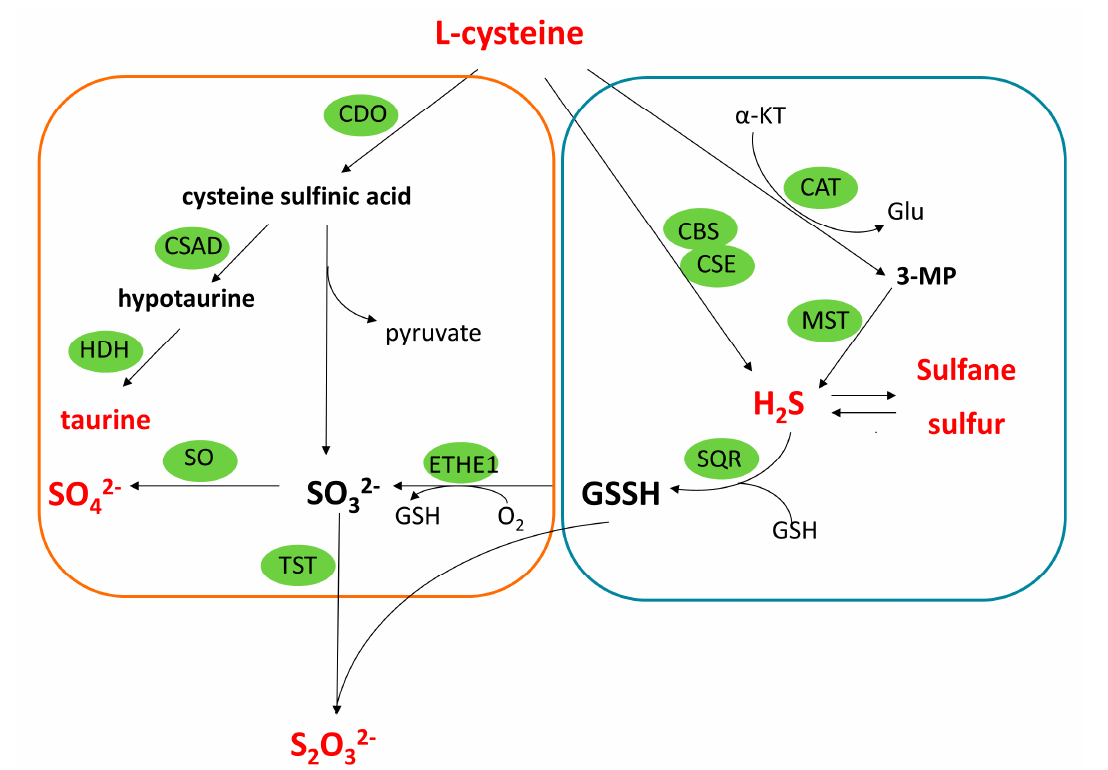
Figure 1. Aerobic (orange frame) and anaerobic (blue frame) catabolism of cysteine. L-cysteine is metabolized by the aerobic pathway in the reaction catalyzed by cysteine dioxygenase (CDO) to cysteine sul fi nic acid, which can undergo decarboxylation catalyzed by cysteine sul fi nic acid decarboxylase (CSAD) leading to hypotaurine formation. The la tt er compound is easily oxidized by